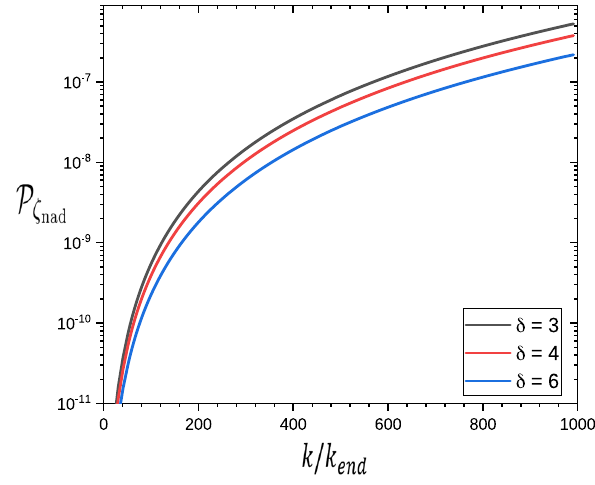
is presented for nad